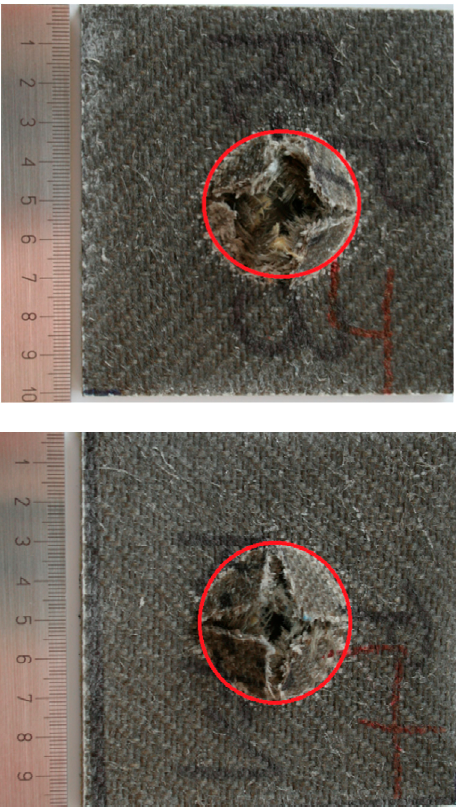
Figure 4. Absorbed energy of EP ‐ laminates.